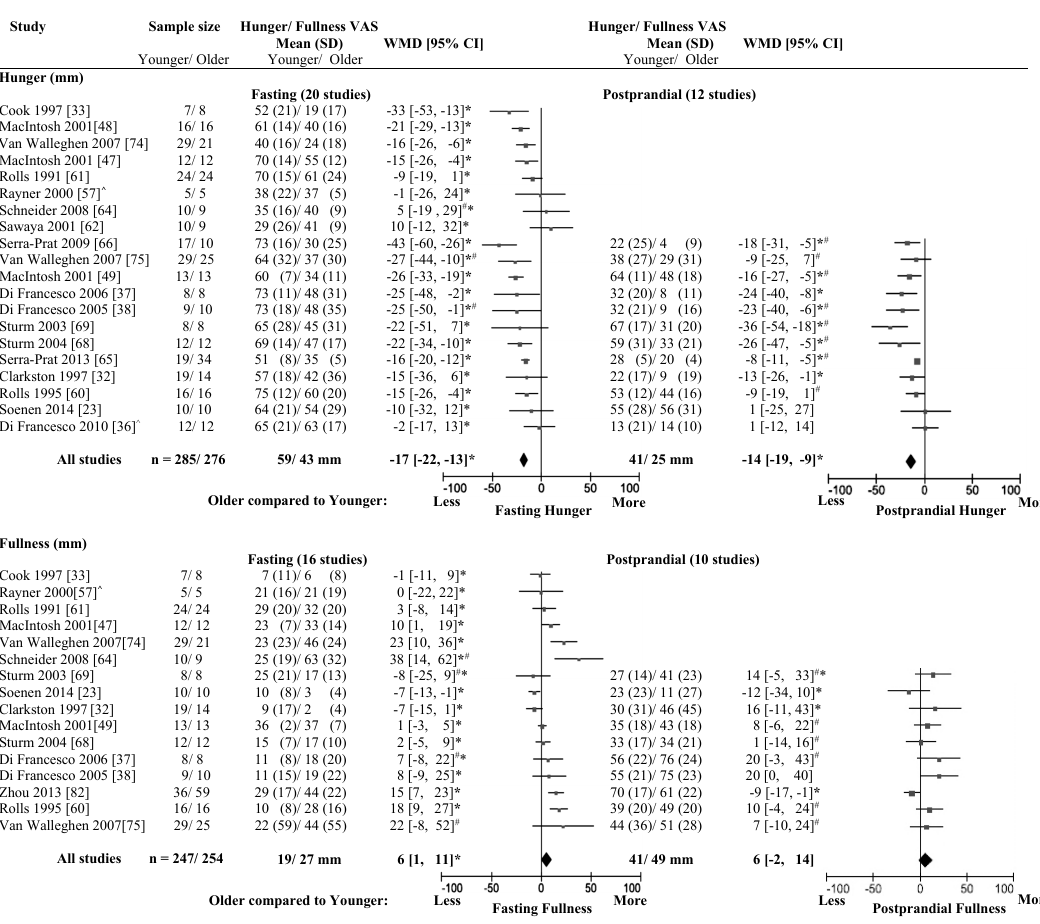
Figure 3. Appetite. Mean ˘ SD of appetite (hunger and fullness; Visual Analogue Scale (VAS; mm)) after overnight fasting and in a postprandial state and a plot of the weighted mean difference (WMD; mm) of appetite in older compared with younger subjects with the DerSimonian and Laird random-effect model. The horizontal lines denote the 95% confidence interval; (cid:4) point estimates (the size of the square corresponds to its weight); (cid:7) the pooled estimate of the age effect. Older compared to younger adults were less hungry (WMD: ´ 17 mm (95% CI ´ 22 to ´ 13 mm), I 2 = 52%, p = 0.004) and more full (WMD: 6 mm 95% CI 1 to 11 mm, I 2 = 76%, p < 0.001) after overnight fasting and less hungry (WMD: ´ 14 mm (95% CI ´ 19 to ´ 9 mm), I 2 = 53%, p = 0.01) in a postprandial state, whereas fullness was comparable (WMD: 6 mm (95% CI ´ 2 to 14 mm), I 2 = 54%, p = 0.02). * p < 0.05 appetite (hunger/fullness) significantly different in older than younger adults within the study; # data were derived from a figure of the original publication; ˆ data were provided by the investigators by e-mail upon